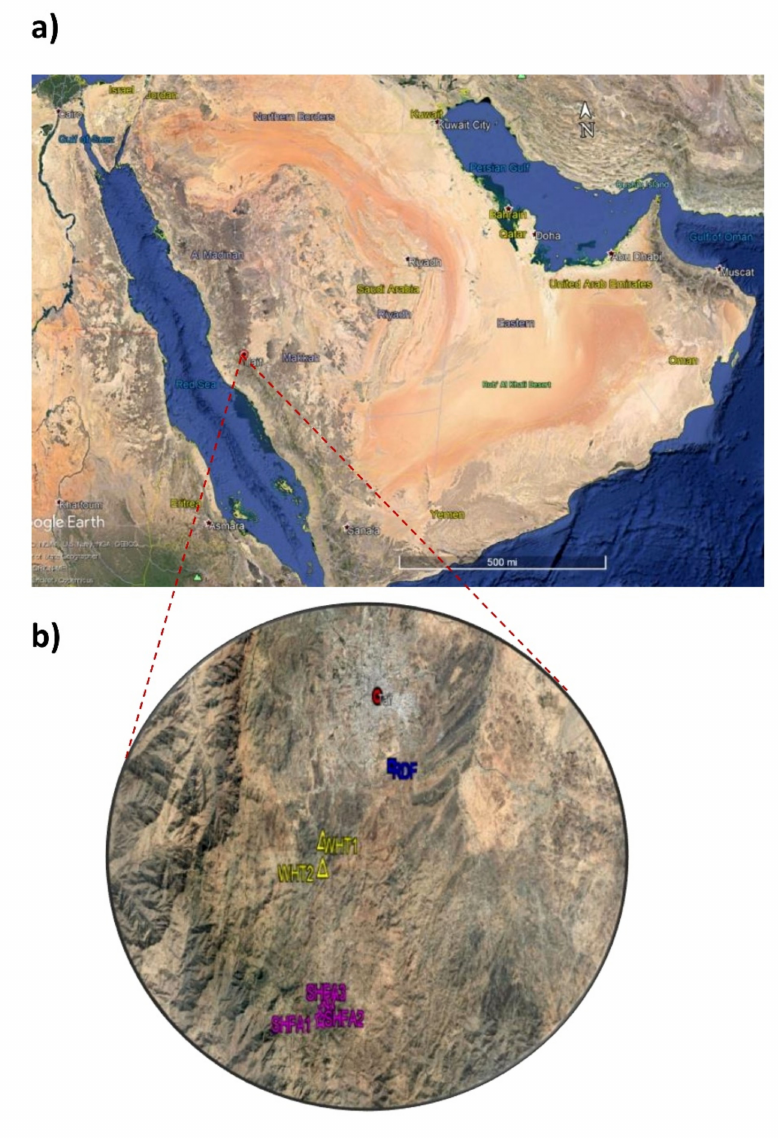
Figure 9. Map of Saudi Arabia displaying the study area location ( a ), and different studied sites ( b ) (Alwaht (WHT), Ash-shafa (SHFA), and Ar Ruddaf (RDF)) in the Taif